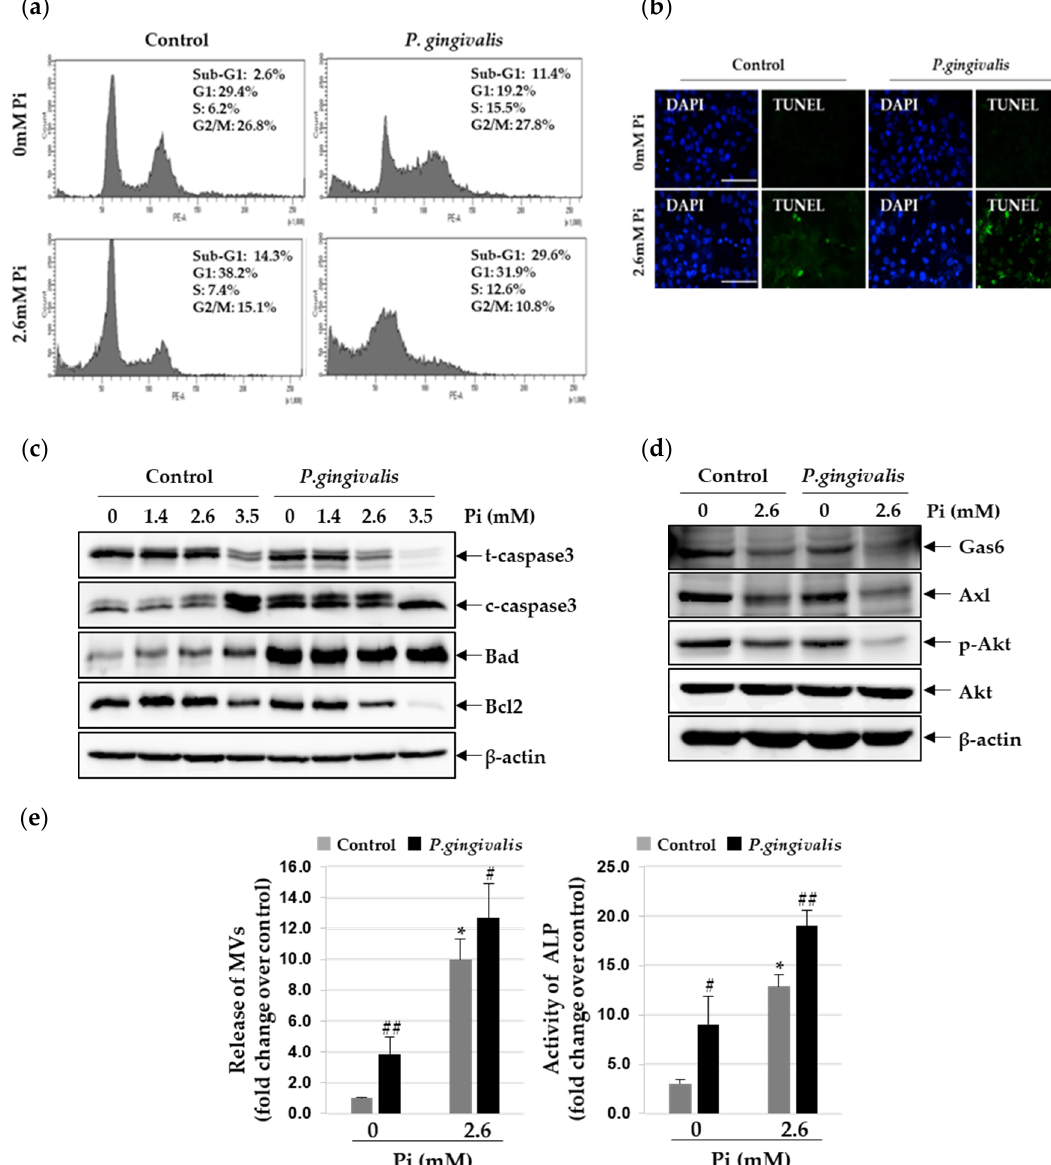
Figure 3. E ff ect of P. gingivalis on Pi-induced apoptosis and matrix vesicle release in VSMCs. P. gingivalis -infected A7r5 cells were cultured in calcification medium (2.6 mM Pi) for three days. ( a ) Induction of apoptosis was determined by flow cytometry analysis with PI staining. ( b ) Apoptosis-associated DNA fragmentation was detected by fluorescent TUNEL (green), and cell nuclei were stained by DAPI (blue). (original magnification, × 400). Scale bar: 50 µ m. ( c ) Total / cleaved-caspase 3, Bcl2, Bad, and β -actin protein levels were examined by Western blotting using their corresponding antibodies. ( d ) Gas6, Axl, p-Akt, Akt, and β -actin protein levels were examined by Western blotting using their corresponding antibodies. ( e ) Matrix vesicles were isolated as described in the Materials and methods section. Alkaline phosphatase activity was measured and normalized to the total protein content of matrix vesicles. * p < 0.01 vs. 0 mM Pi, # p < 0.05; ## p < 0.01 vs. control, one-way ANOVA followed by a Student’s t -test. Data shown are the mean ± SD, obtained for at least three independent